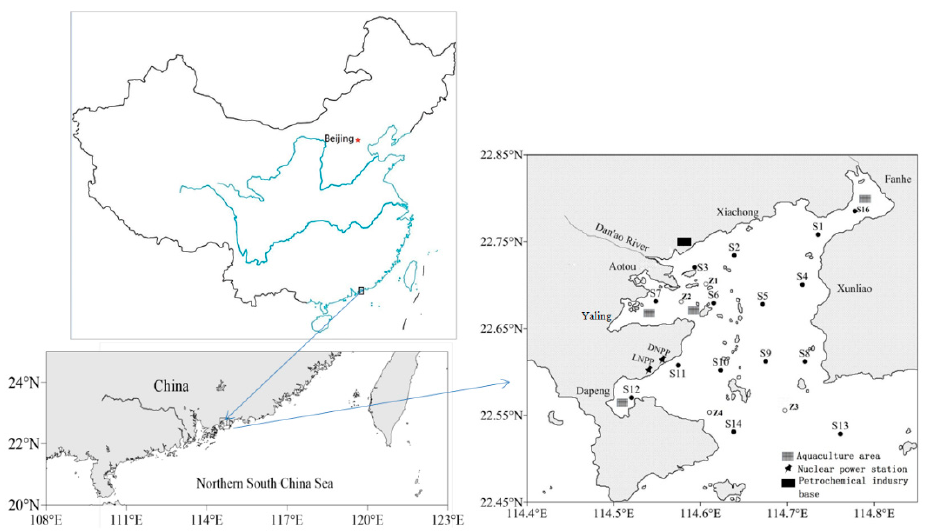
Figure 1. Daya Bay location and sampling sites (Labeled as S1-S14, S16, and Z1-Z4).